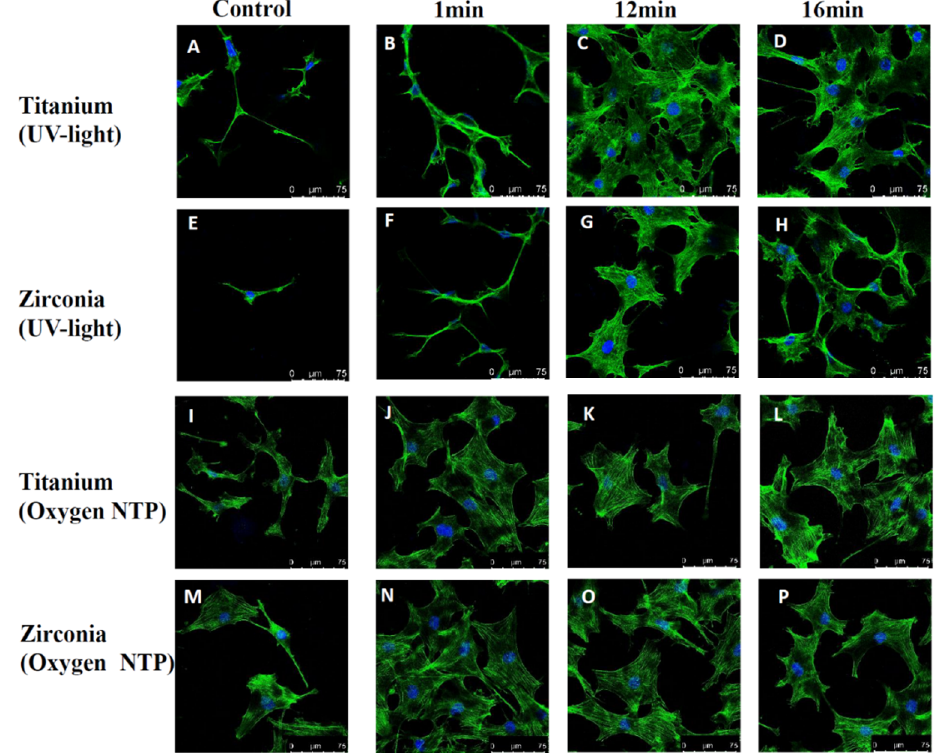
Figure 3. Representative examples of cytoskeleton stained with phalloidin after 24 h of incubation on controls ( A , E , I , M ), 1, 12, 16 min UV-light treated ( B – D , F – H ) and 1, 12, 16 min oxygen plasma treated ( J – L , N – P ) surfaces of titanium and zirconia using confocal microscopy.